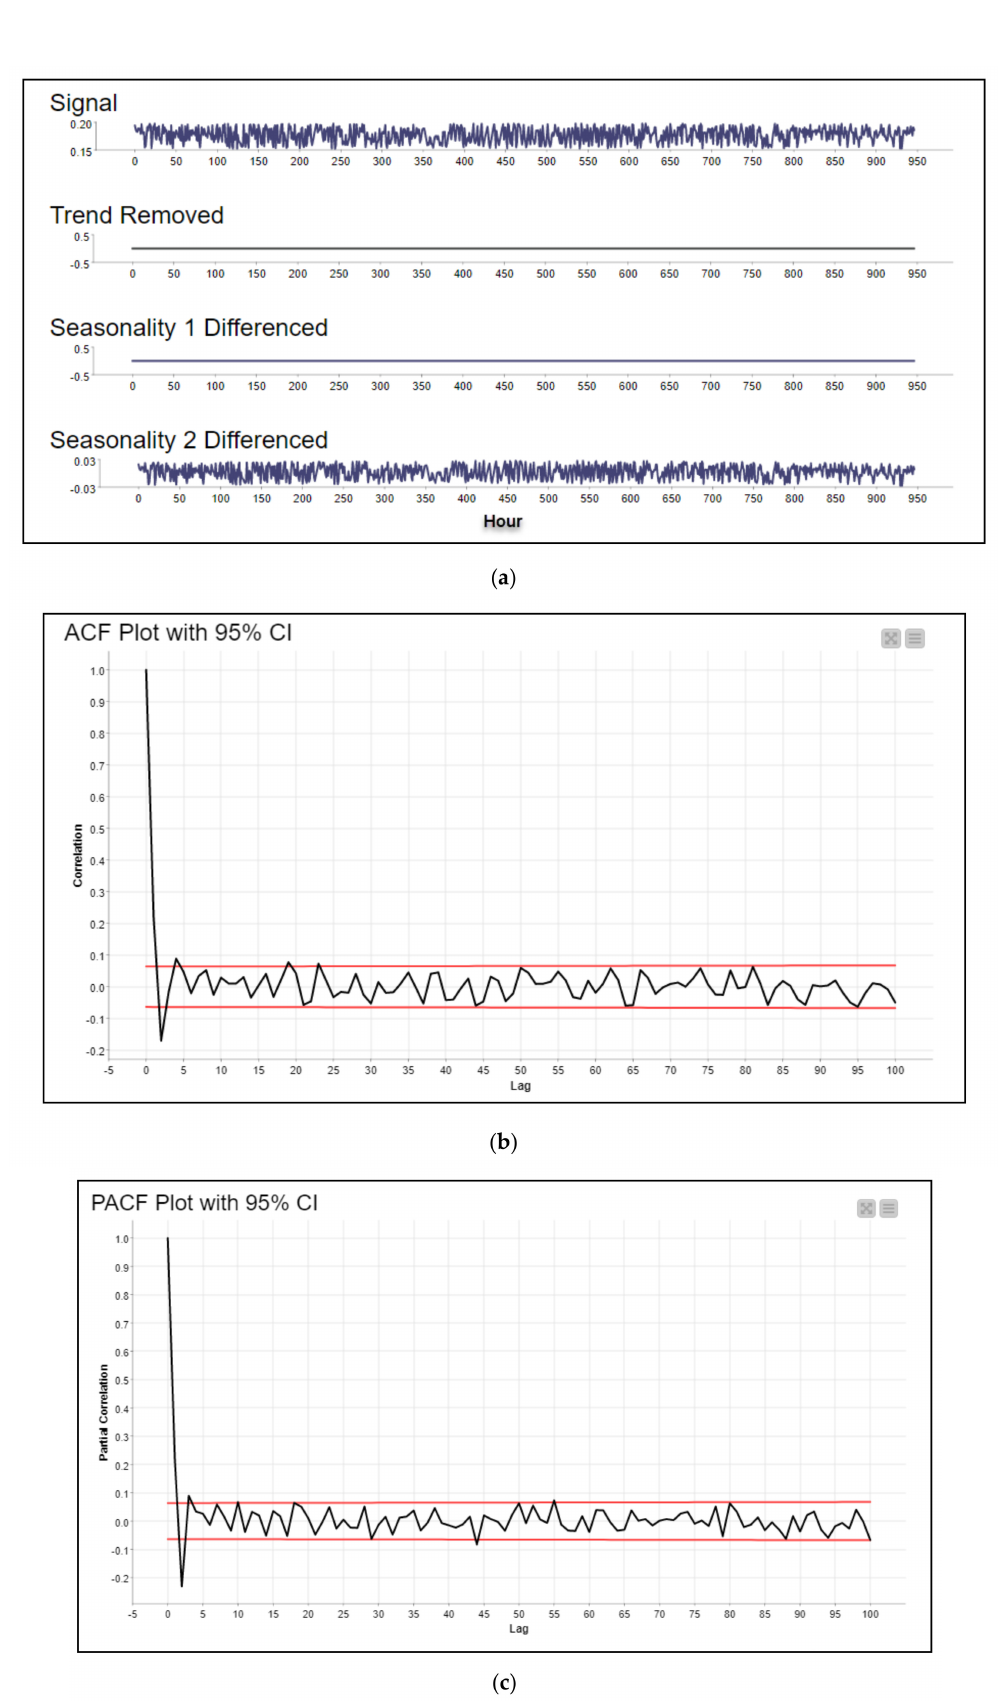
Figure 17. ( a ) Signal, Trend, and Seasonality Differences of Cluster 0; ( b ) The Autocorrelation (ACF) of Decomposition Signal of Cluster 0; ( c ) The Partial Autocorrelation Function (PACF) of Decomposition Signal of Cluster